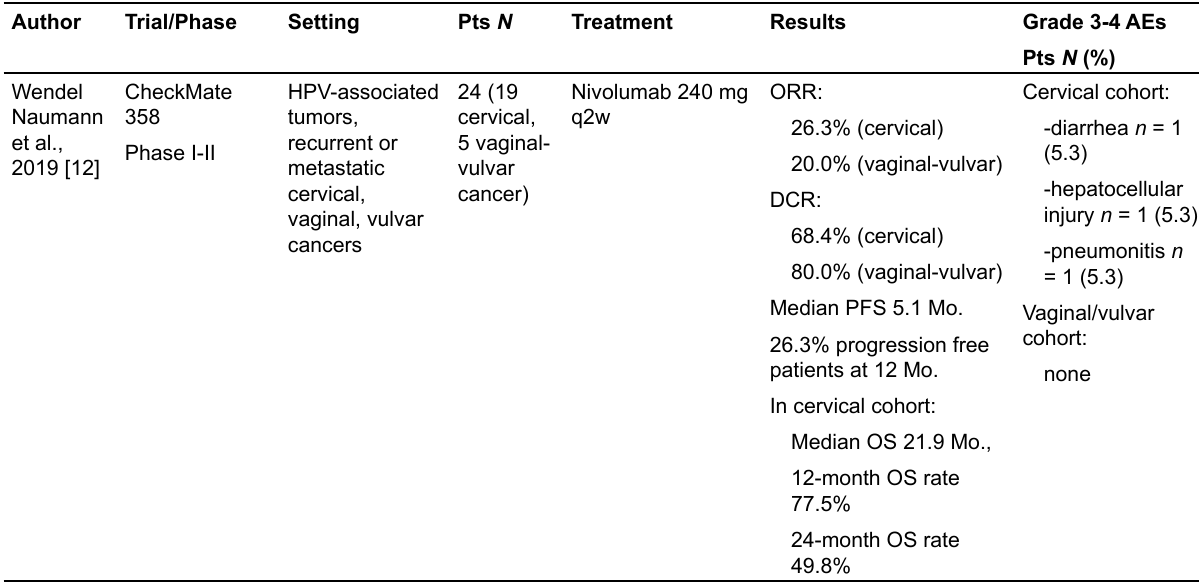
Table 1. Clinical trials in CC ( continued